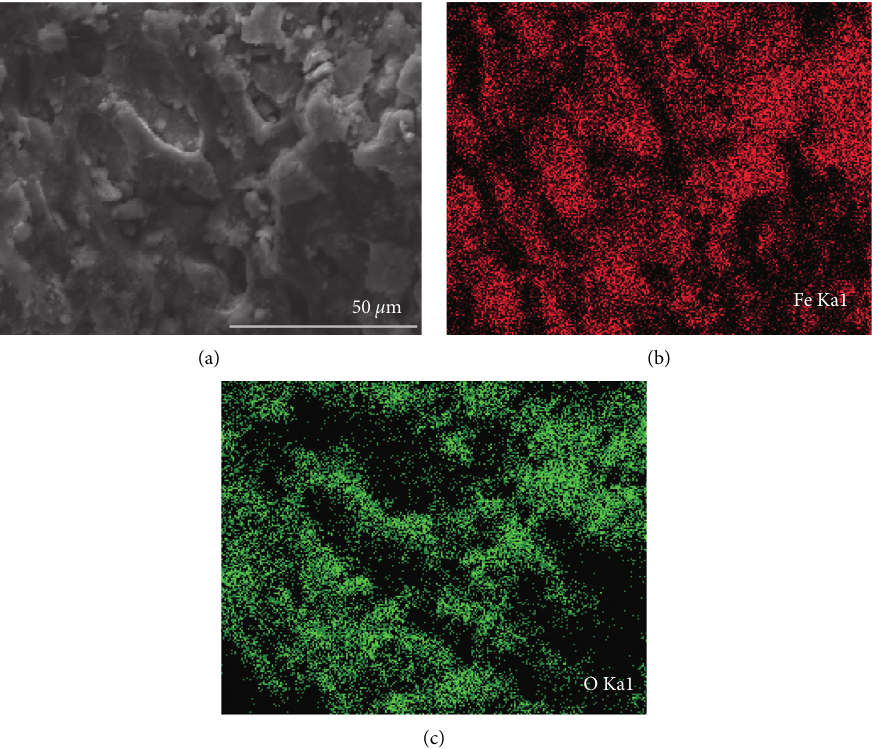
Figure 4: SEM image (a) and EDX elemental mapping of Fe (b) and O (c) of the AC/Fe